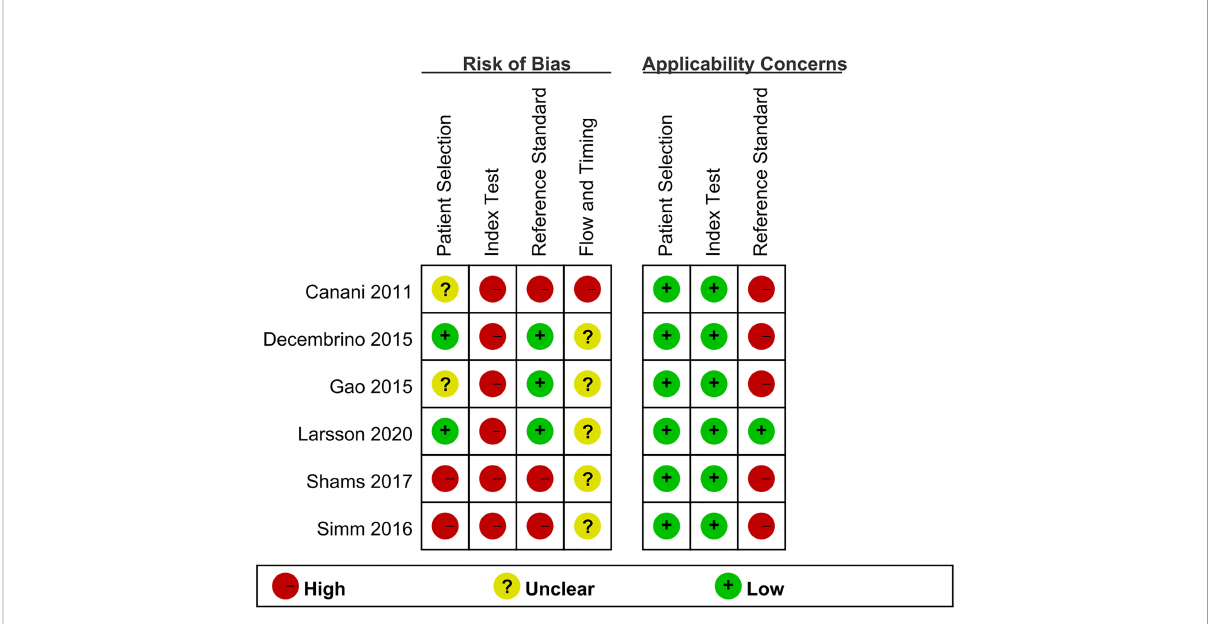
FIGURE 2 Risk of bias and applicability concerns of the included studies.